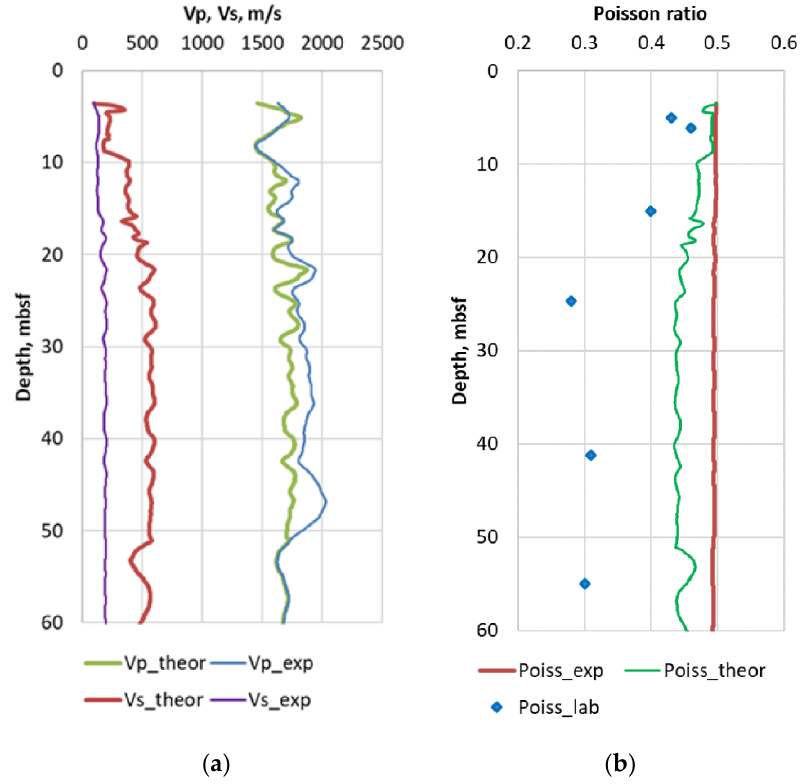
Figure 6. Comparison of seismic data (exp), results of rock-physics modeling (theor), and laboratory data (lab): ( a ) velocities of P- and S-waves and ( b ) Poisson’s ratio.